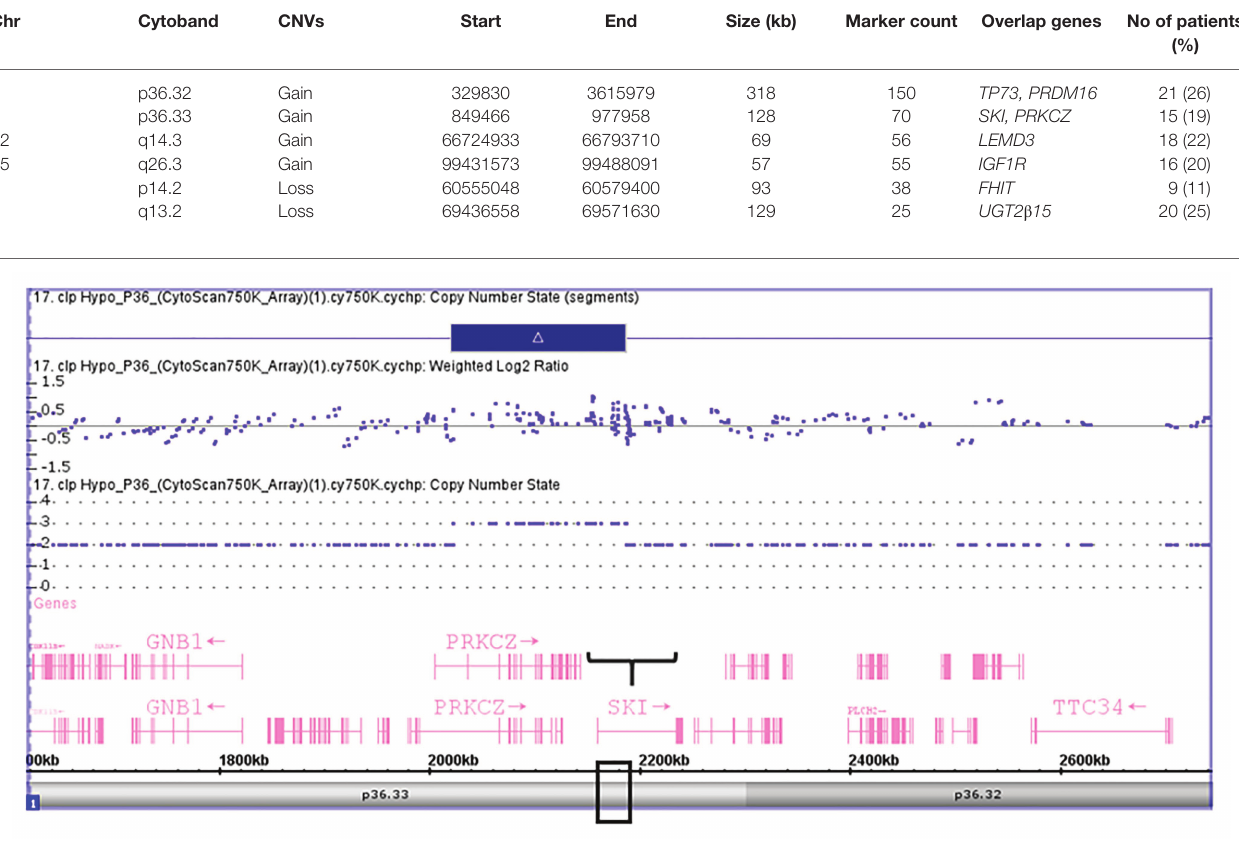
FIGURE 1 | Microarray-based copy number analysis performed with the Affymetrix CytoScan 750K array and visualized using the Affymetrix Chromosome Analysis Suite version 1.2.2. Image of the 116 kb gain at 1p36.33 (Chromosome 1: 2021784-2187344, GRCH37/hg19) present in a boy 10 year-old. The region overlaps with SKI (black